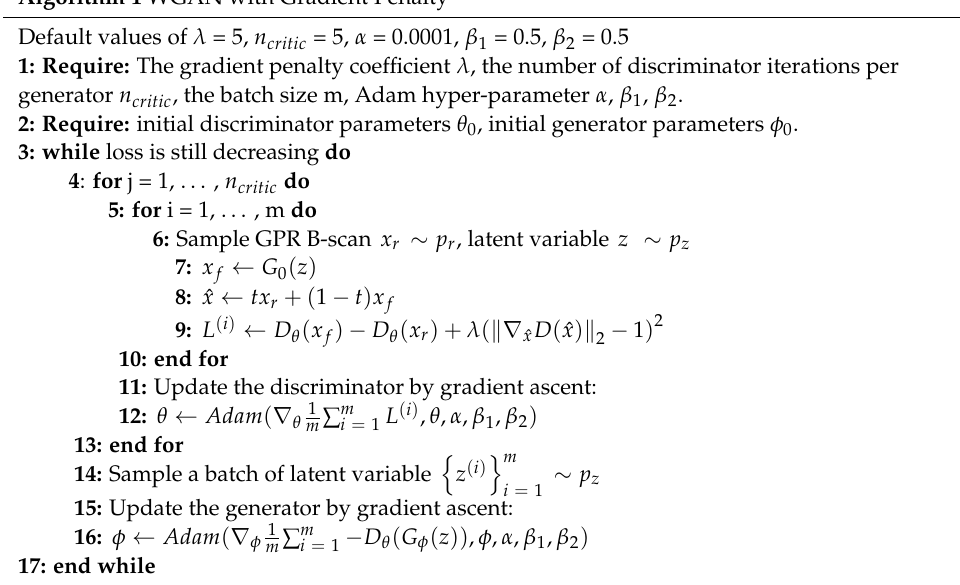
Algorithm 1 WGAN with Gradient